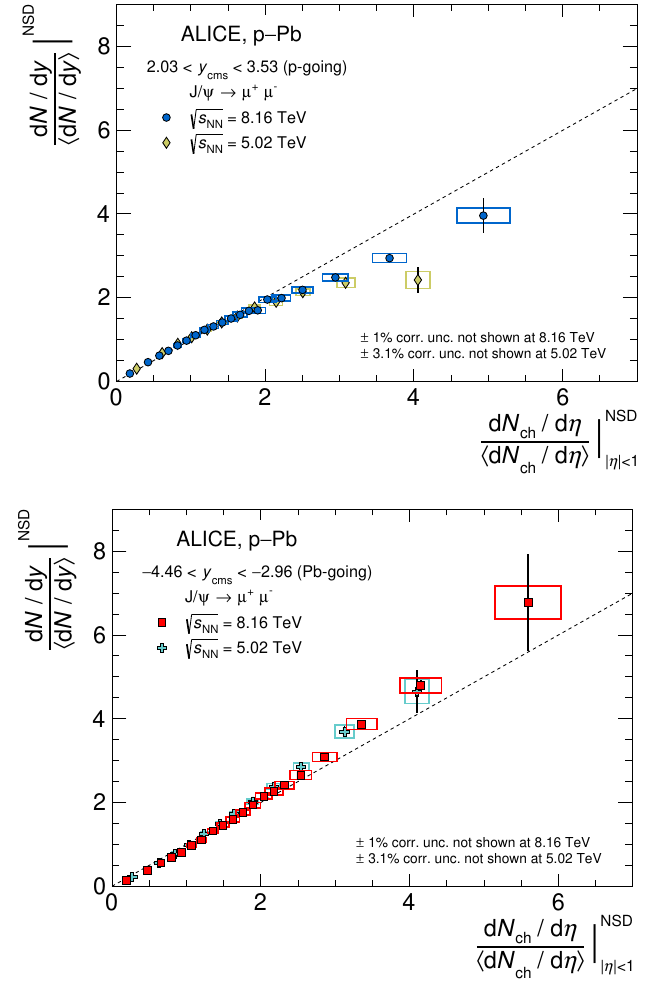
Figure 6 . Normalized yield of inclusive J = as a function of the normalized charged-particle pseudorapidity density, measured at midrapidity, in p-Pb collisions at p s NN = 5 : 02 TeV [26]. The top (bottom) panel presents the measurement at forward (backward) rapidity. The vertical bars represent the statistical uncertainties, the boxes the systematic ones. The dashed line indicates the one-to-one correlation, to guide the